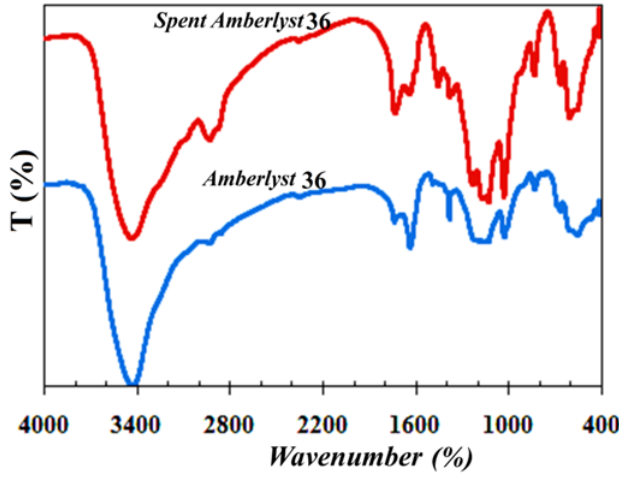
Figure 7. FT ‐ IR spectra of the Amberlyst 36 before and after reaction.